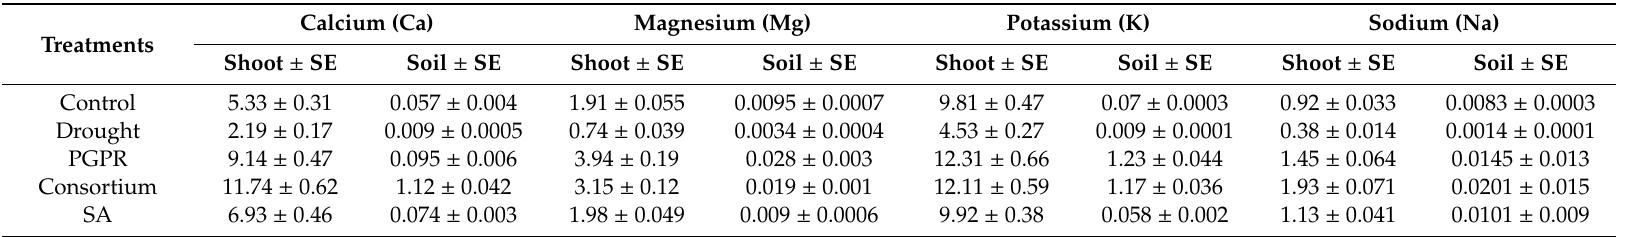
Table 5. Macronutrient accumulation (mg / kg) in the shoot and rhizosphere of sensitive variety grown under rainfed conditions. Treatments